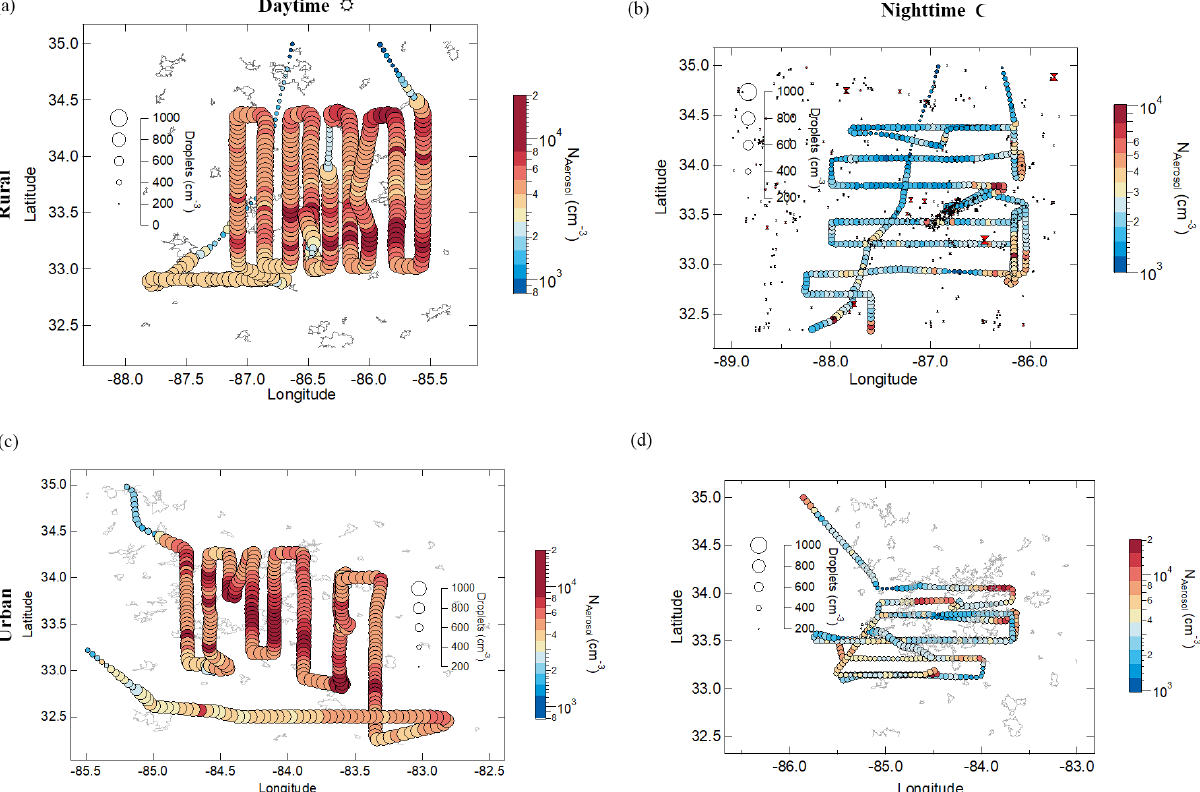
Figure 3. Map of aircraft flight tracks showing calculated cloud droplet number (indicated by marker size in cubic centimeters) and total aerosol number (indicated by marker color) for the observed characteristic vertical velocity ( w ∗ ). (a) For the rural sector during daytime (Flight 5) and (b) nighttime (Flight 15). (c) For urban Atlanta during daytime (Flight 6) and (d) nighttime (Flight 9). Note that the plotted data are 1min averaged in order to better show the size and color of the